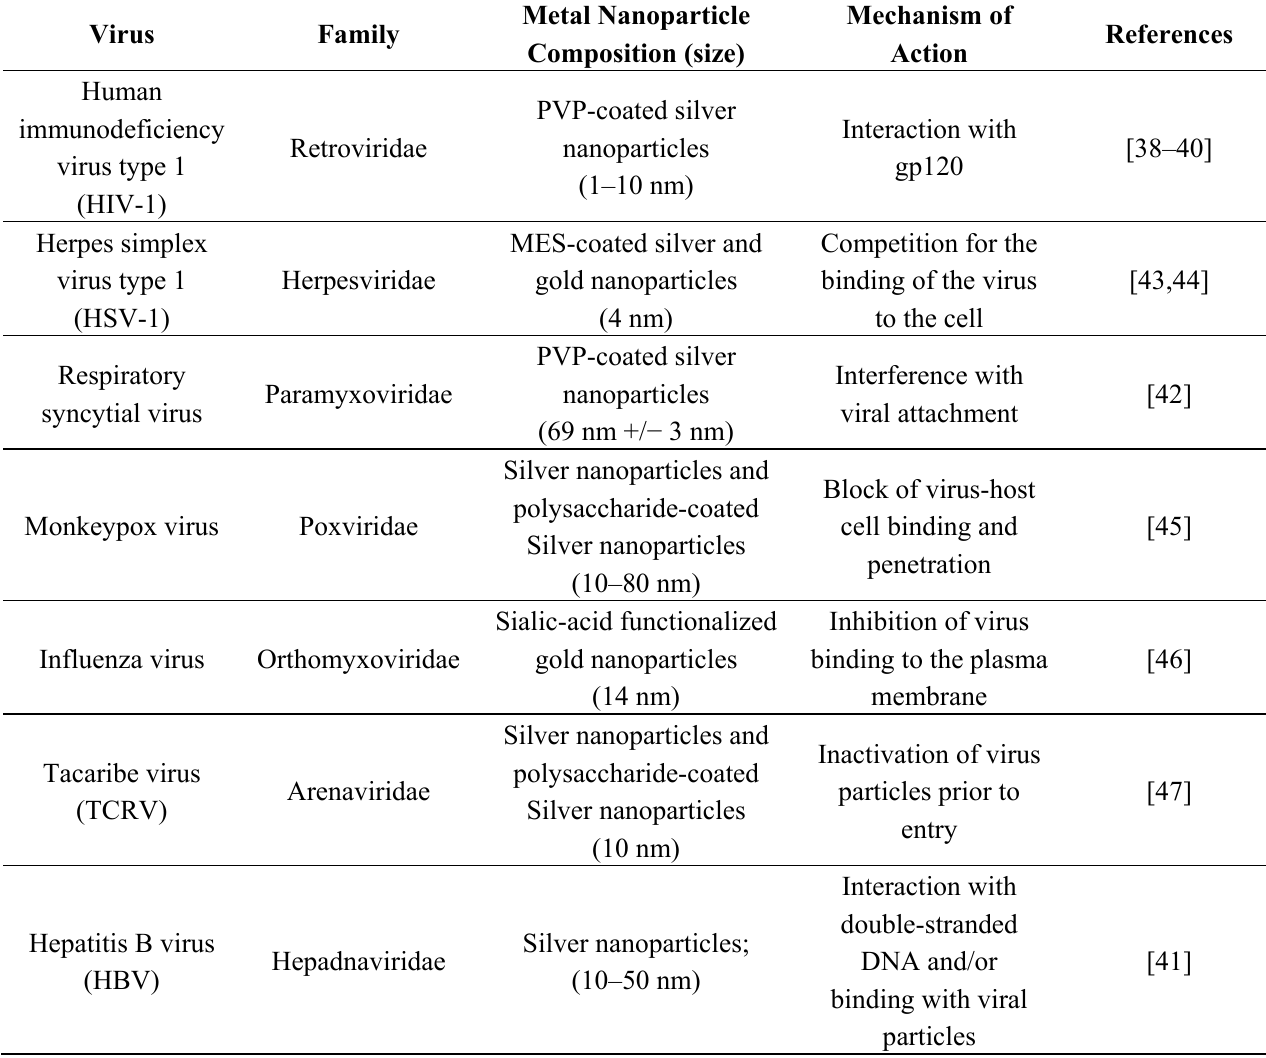
Table 1. Antiviral metal